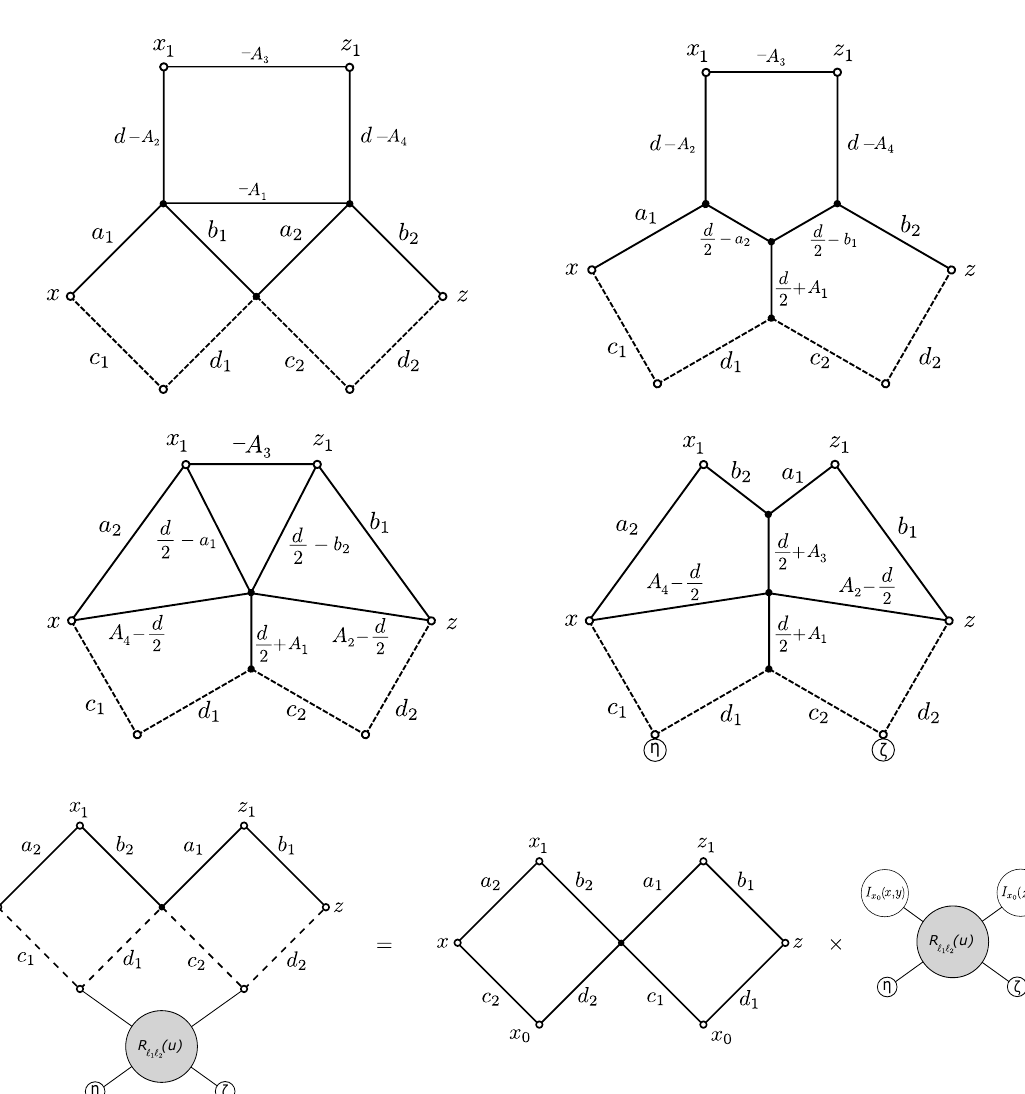
Figure 6 . Top left: l.h.s. of the interchange relation after multiplication by the inverse of the square kernel. Top right: the central triangle ( − A 1 , a 2 , b 1 ) is transformed into a star integral. Middle left: result of star-triangle identity in the vertices ( a 1 , d − A 2 , d/ 2 − a 2 ) and ( b 2 , d − A 4 , d/ 2 − a 1 ) . Middle right: the triangle ( − A 3 , d/ 2 − a 1 , d/ 2 − b 2 ) is transformed into a star integral. Bottom: result of the integration of the vertex ( d 1 , c 2 , d/ 2 + A 1 ) . The tensors I x by a non-trivial operator acting on V l 1 ⊗ V l 2 , the matrix R l